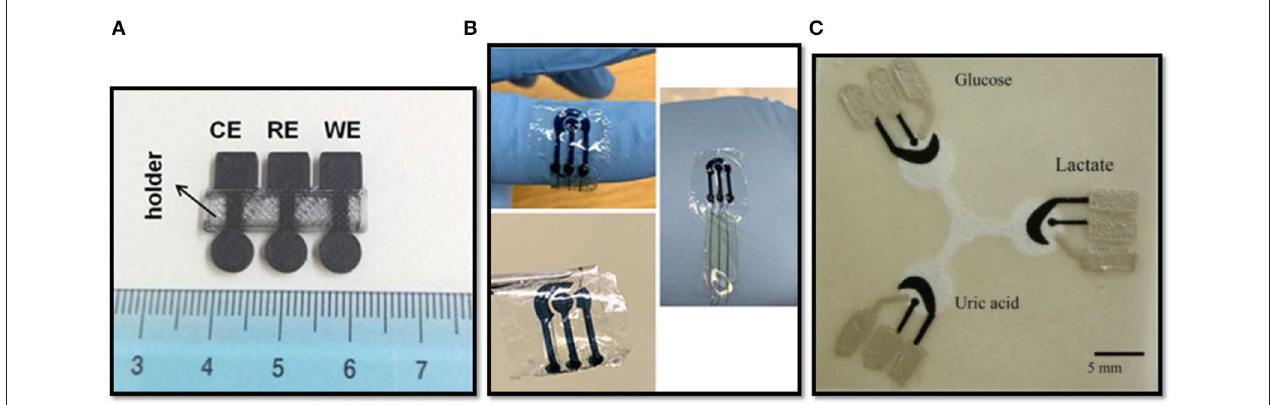
FIGURE 2 | (A) 3D-printed 3-electrode integrated device made with PLA filaments, reprinted with permission from Katseli et al. (2019); (B) PEDOT:PSS patterns on flexible silk fibroin sheets, reprinted with permission from Xu et al. (2019); (C) Paper-based microfluidic electrochemical chip, reprinted with permission from Dungchai et al.